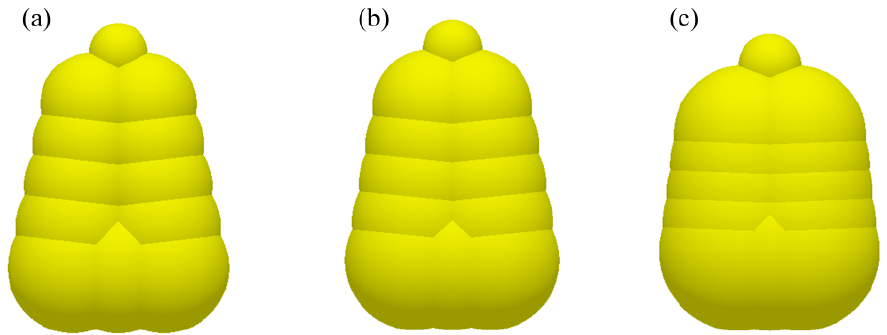
Figure 4. Particle models of the horse-tooth-shaped seed of three varieties: ( a ) Liangyu99, ( b ) Xianyu 335, and ( c ) Zhengda 999.